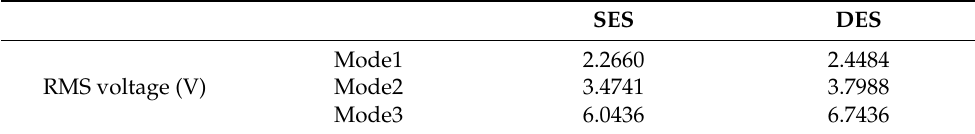
Table 4. SES and DES system theoretical output voltage (with dimension (volt)).